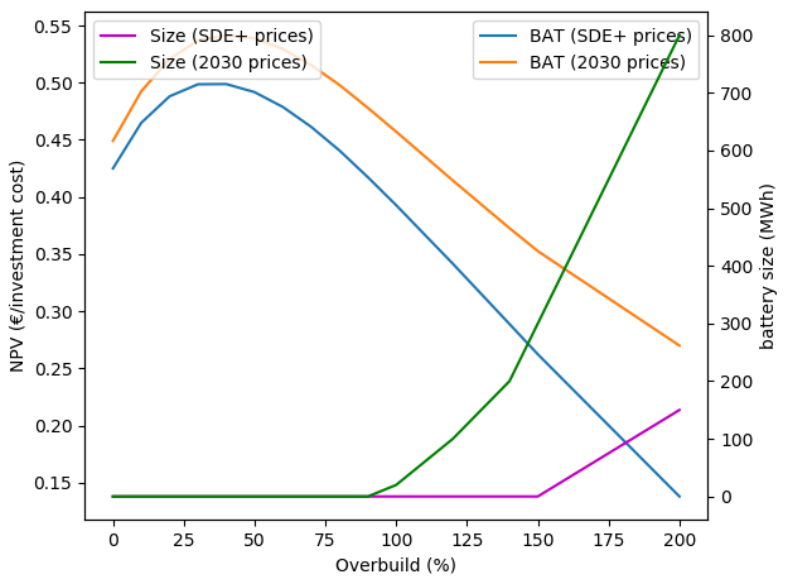
Figure 5. The optimal battery system size (right axis) at each overbuild factor for achieving the highest NPV / I (left axis) for the CUR scenario.